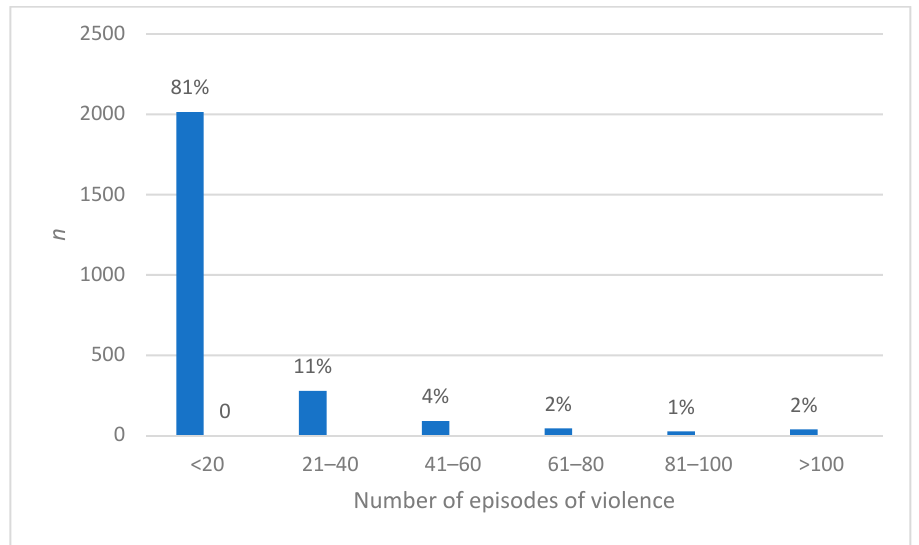
Figure 1. Episodes of violence experienced by nurses and midwives.